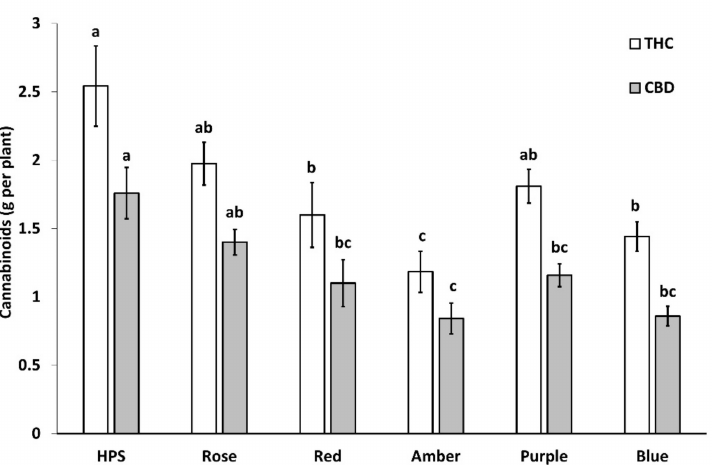
Figure 4. Effect of light treatment on THC and CBD yield per plant. Treatments are high-pressure sodium (HPS), rose (430 + 630 nm, B:R ratio 1:10), red (630 nm), amber (595 nm), purple (430 + 630 nm, B:R ratio 2:1), and blue (430 nm). Values presented in mean and SE (g plant − 1 ; n = 3). Different letters (a, b, c) above the bars represent a significant difference between treatments by Tukey HSD ( p < 0.05).